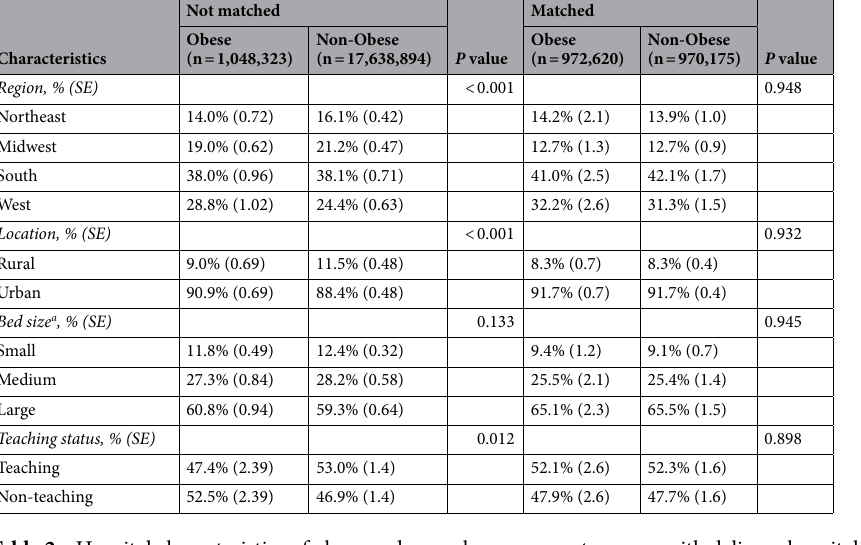
Table 2. Hospital characteristics of obese and non-obese pregnant women with delivery hospitalizations. a Bed size categories are based on hospital beds and are specific to the hospital’s location and teaching status. For details of categorization, please see: https:// www. hcup- us. ahrq. gov/ db/ vars/ hosp_ bedsi ze/ nisno te. jsp.